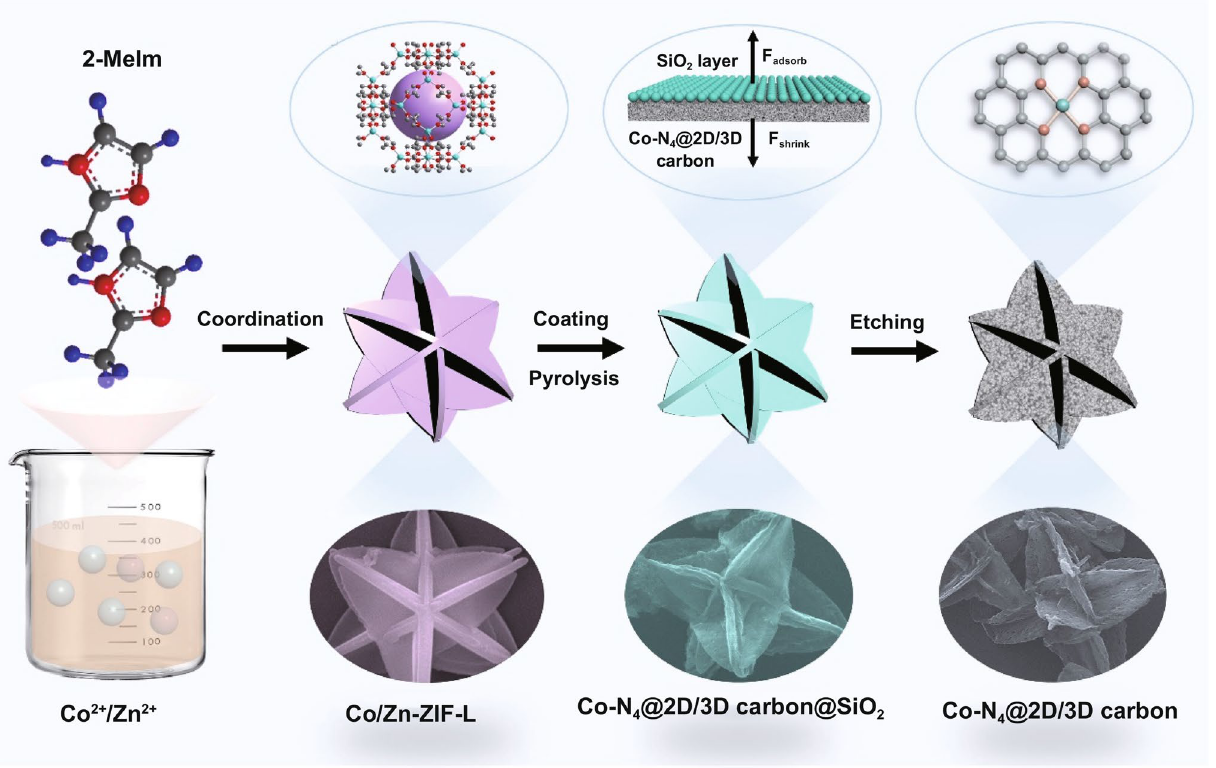
Fig. 1 Schematic synthesis procedure of Co–N 4 @2D/3D